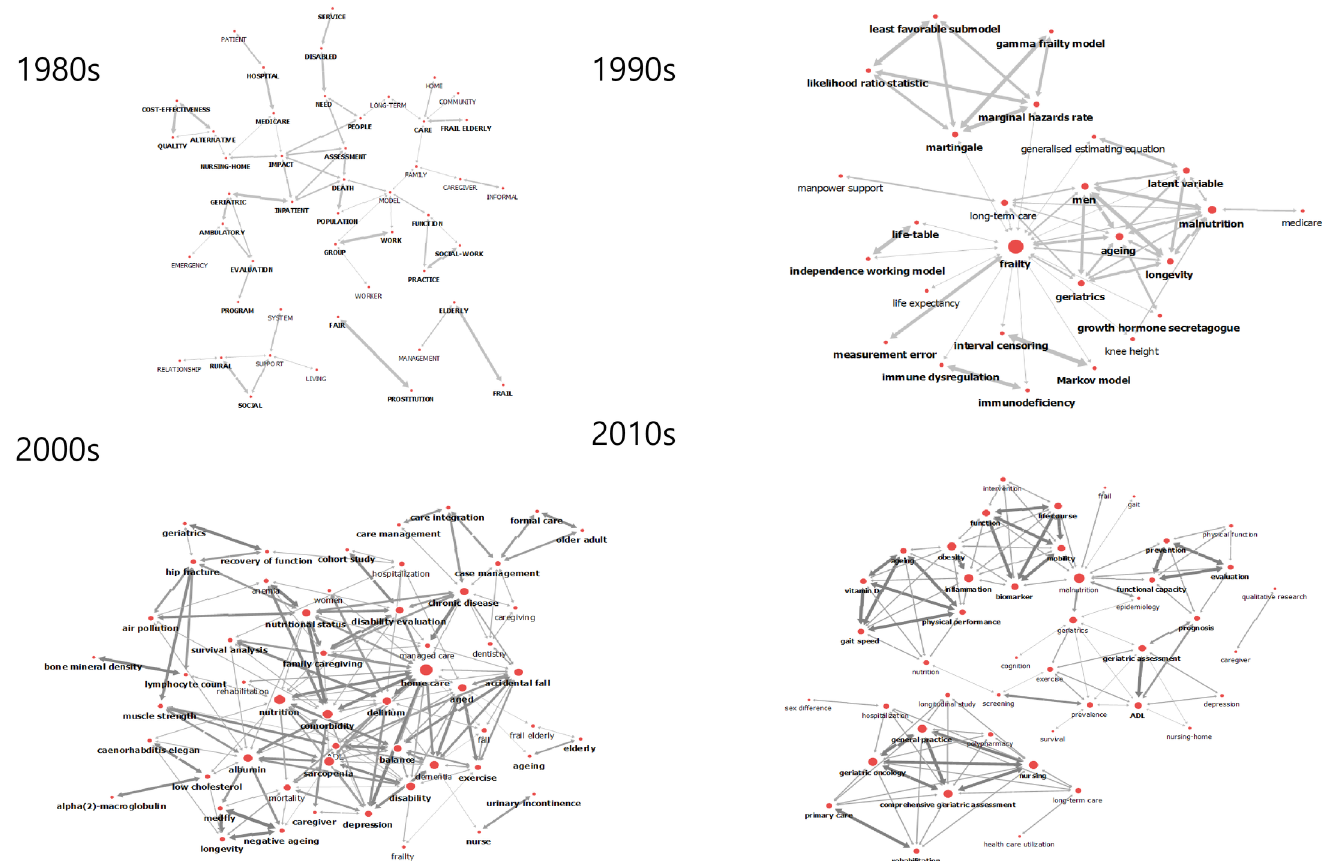
Fig 1. Degree centrality trend through 40